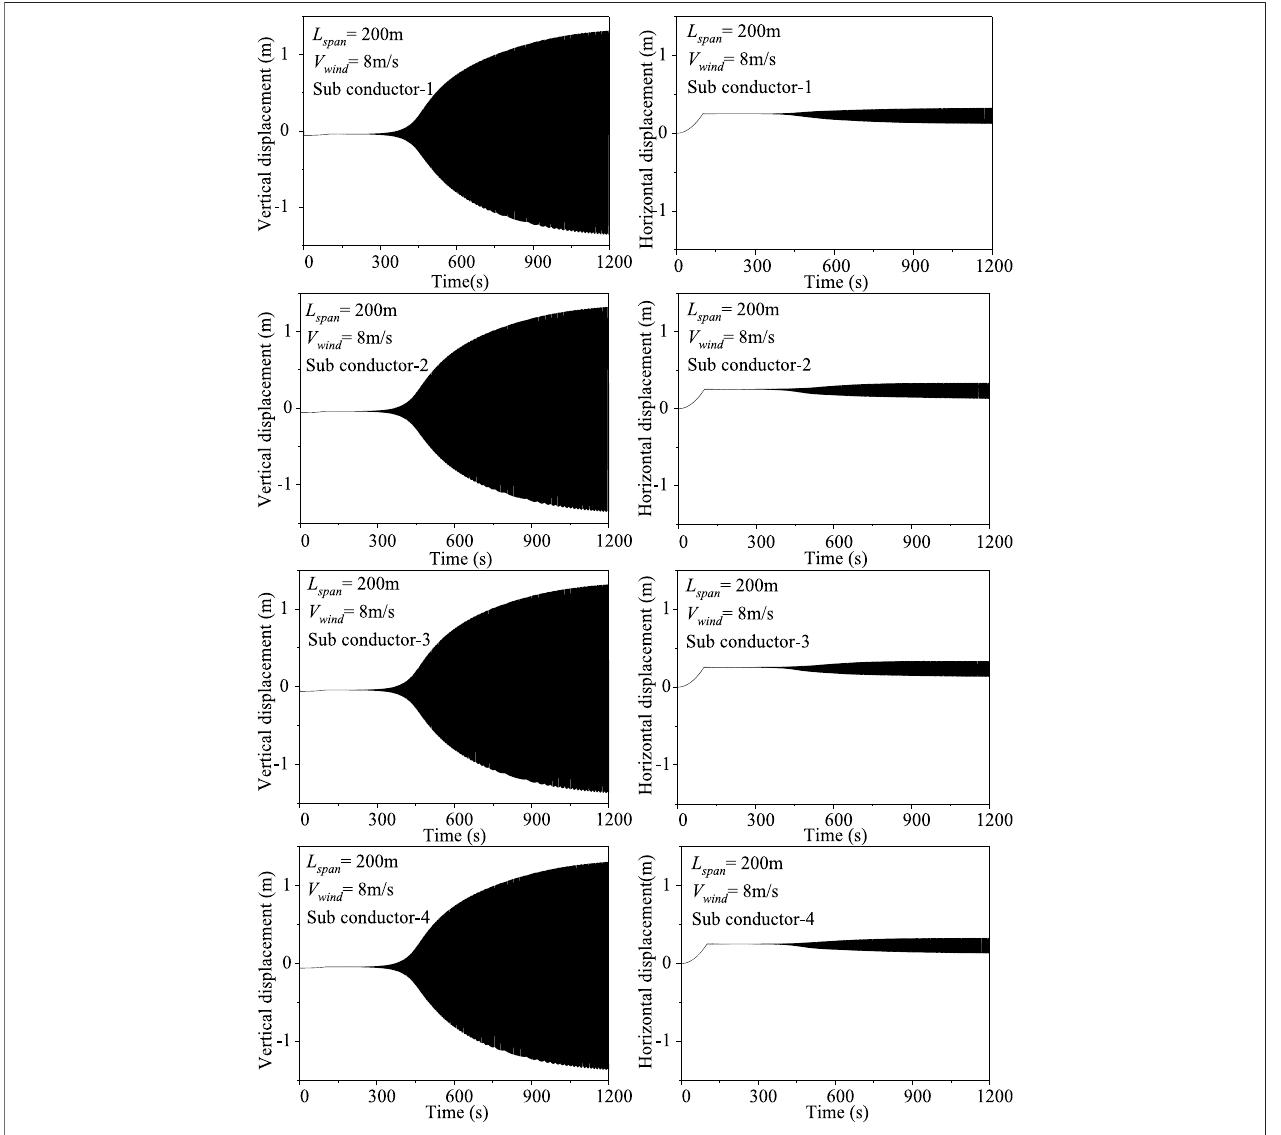
FIGURE 3 | Time history of midpoint displacement of the iced eight-bundle conductor under a wind velocity of 8 m/s (200 m span).